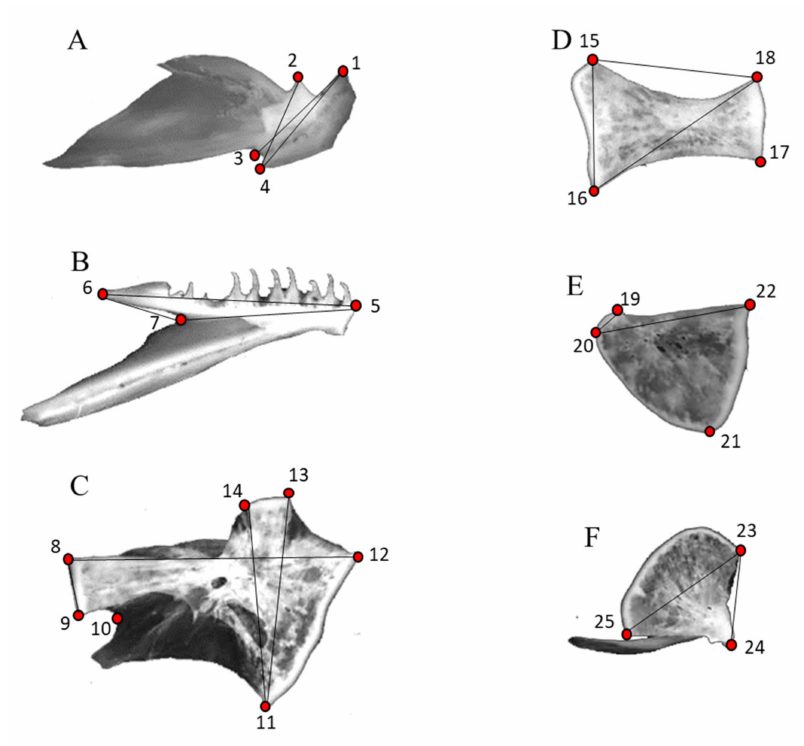
Figure 1. Cranial bones and landmarks used for morphological analysis of Atlantic salmon: ( A )—Articulare, ( B )—Dentale, ( C )—Hyomandibulare, ( D )—Ceratohyale, ( E )—Epihyale, ( F )—Quadrate. Twenty-five landmarks are designated with red points. Distances between all land- marks in one bone, 45 in total, were used as traits. These traits were used for construction of 39 indices (ratios between traits, see Supplement Table S1). Eleven of these 39 indices, which did not show correlation with size, were selected for further analysis. The lines show traits which were used for construction of these 11 indices (Supplement Table